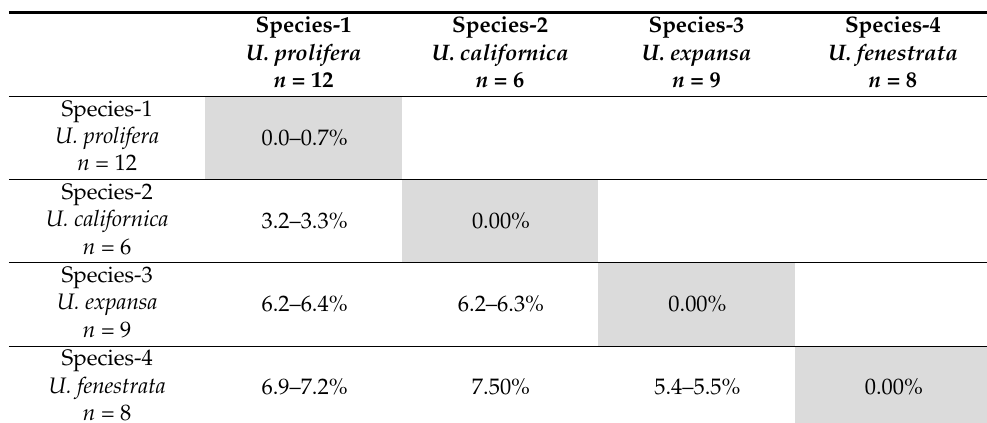
Table 2. Intra- and interspecific divergences among tufA sequences from 35 specimens of four blade- form Ulva species collected in the San Juan Islands, WA. Gray background = intraspecific divergences; white background = interspecific